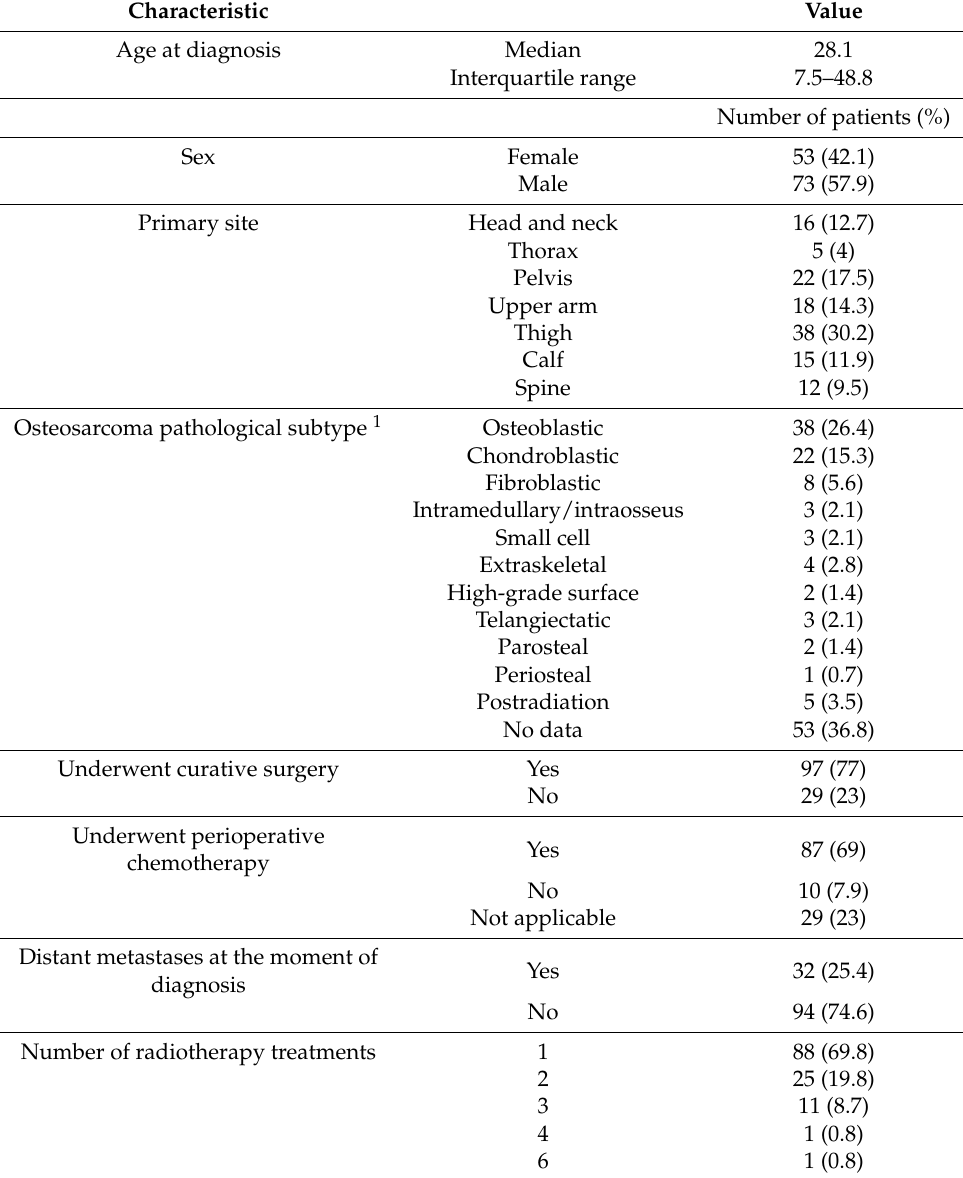
Table 1. Patients’ and treatments’